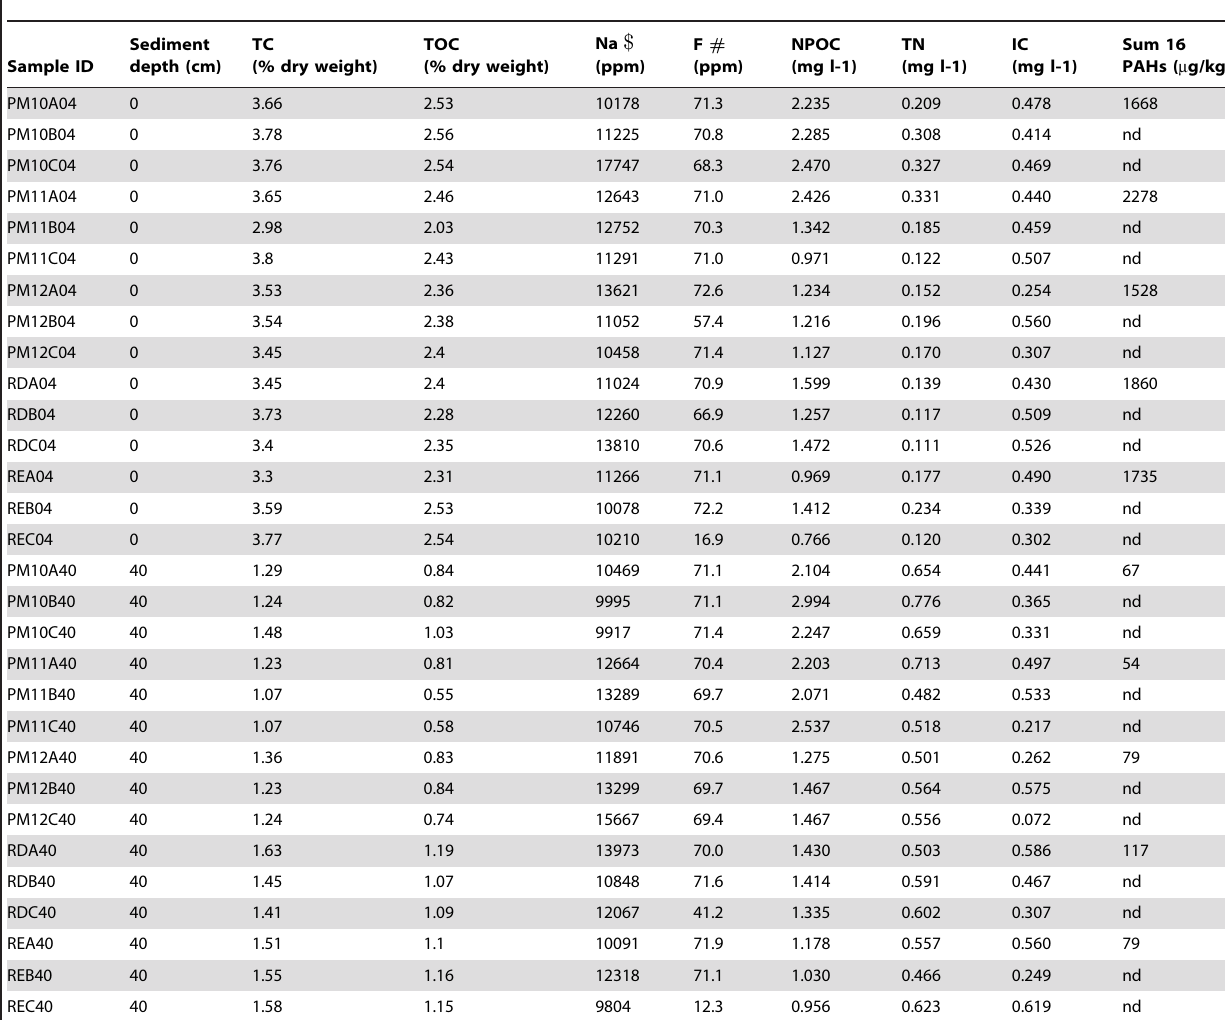
Table 2. Overview of a selection of chemical variables measured per